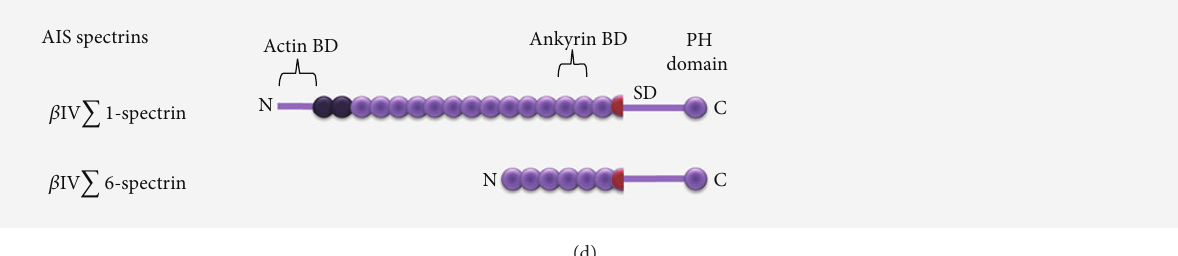
Figure 1: Architecture of the axon initial segment (AIS) and its key protein components. ((a), top) Neuron polarity. Polarized neurons receive synaptic inputs in the somatodendritic domain (green), which transmits the signals through the axon hillock to the axon initial segment (red). The AIS integrates synaptic inputs and initiates an action potential that gets propagated along the distal axon (blue) and amplified at nodes of Ranvier. ((a), bottom) Molecular organization of the AIS. The AIS can be divided into three layers: the plasma membrane, submembrane cytoskeleton, and inner AIS shaft (left), each having AIS-specific features (zoomed view at right). The scaffolding protein ankyrin G (AnkG) recruits many other proteins to the AIS and can interact with components in the different AIS regions. In the plasma membrane, AnkG through its N-terminal membrane-binding domain binds voltage-gated ion channels, which are important for action potential initiation and regulation, and cell adhesion molecules (CAMs). The submembrane cytoskeleton contains AnkG, 𝛽 IV-spectrin, and actin filaments. These proteins form a periodic network along the entire length of the AIS. Periodic actin is spaced ∼ 190 by at least two 𝛽 IV-spectrin subunits, which in turn attach to the membrane through interactions with AnkG. In addition to periodic actin, relatively long, randomly oriented, dynamic actin filaments also exist in the submembrane cytoskeleton, and these filaments may have functions distinct from periodic actin. The inner AIS shaft contains microtubules bundles (fascicles), neurofilaments, and potentially also actin filaments (not shown). AnkG can extend its C-terminal tail into the inner AIS shaft where it is predicted to interact with microtubule fascicles. (b) Domain organization of isoforms of ankyrin G (AnkG). AnkG population contains two large neuron-specific isoforms, 270 kDa and 480 kDa, that localize specifically to AIS and nodes of Ranvier. The N-terminal membrane-binding domain of AnkG contains 24 ANK repeats (33-amino acid motif that mediates protein interactions). These 24 ANK repeats fold to form four independent subdomains (each containing 6 ANK repeats) that compose a globular membrane-bindingdomain.Thespectrin-bindingdomainallowsinteractionswith 𝛽 IV-spectrinandtherebyattachmentofthesubmembrane cytoskeleton to the membrane. The serine-rich domain is glycosylated with N-acetylglucosamine monosaccharides. 480 kDa AnkG contains a 220 kDa insert following the spectrin-binding domain that is predicted to form a random coil. (c) Domain organization of typical 𝛼 - and 𝛽 -spectrin isoforms. (Top) 𝛼 -spectrin comprises an incomplete spectrin repeat at the N-terminus (red), 20 complete spectrin repeats (violet), an SH3 (Src homology 3) domain (dark blue) inserted into spectrin repeat 9, and two EF-hand motifs at the C-terminus. Last two spectrin repeats (dark violet) can interact with the first two spectrin repeats in 𝛽 -spectrin to form an antiparallel dimer. (Middle) 𝛽 -spectrin comprises an N-terminal actin-binding domain (BD), 16 full spectrin repeats (violet), an incomplete 17th spectrin repeat (red), a variable region specific for individual 𝛽 -spectrin isoforms (specific domain, SD), and a C-terminal pleckstrin homology (PH) domain. Spectrin repeats 1 and 2 (dark violet) dimerize with 𝛼 -spectrin; spectrin repeats 14 and 15 interact with AnkG. (Bottom) A typical spectrin molecule represents an 𝛼𝛽 - heterotetramer (two 𝛼 - and two 𝛽 -subunits) that form a rod-shaped structure. Two 𝛼𝛽 -spectrin dimers, each formed by transverse interaction between 𝛼 -spectrin repeats 19 and 20 and 𝛽 -spectrin repeats 1 and 2, associate with each other longitudinally by making complete spectrin repeats through pairwise interaction of the incomplete spectrin repeats at the N-terminus of 𝛼 -spectrin and the C-terminus of 𝛽